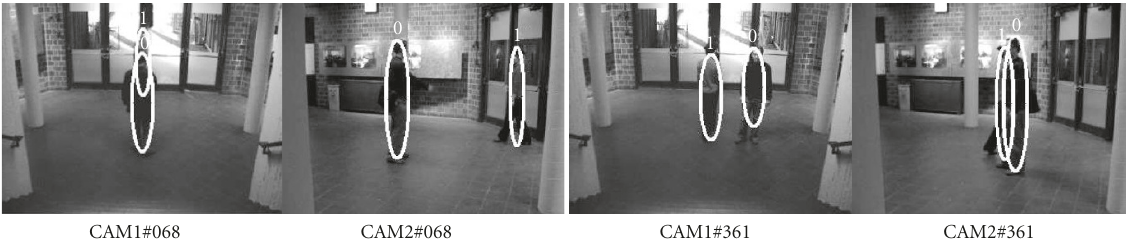
Figure 8: Tracking results of the proposed BMCT on the indoor gray videos Hall